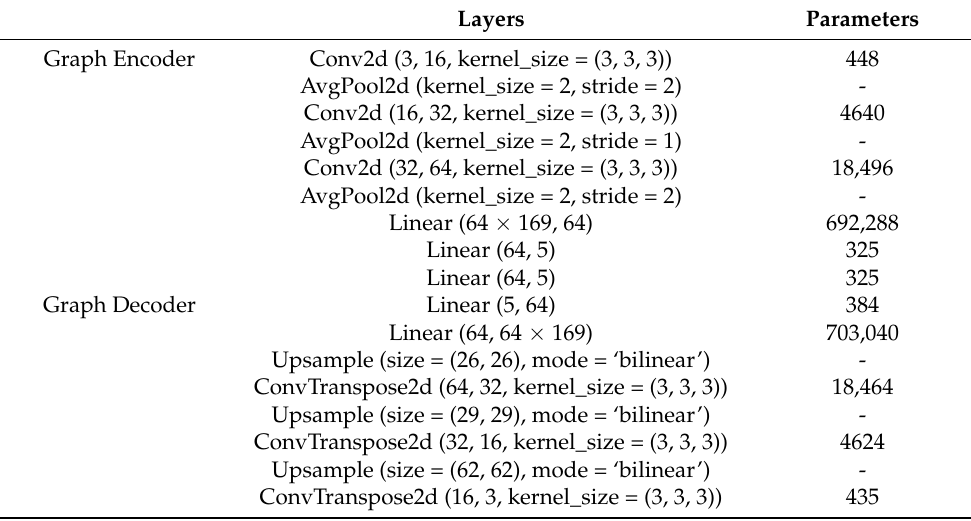
Table A3. Two-dimensional CNN VAE for sprite